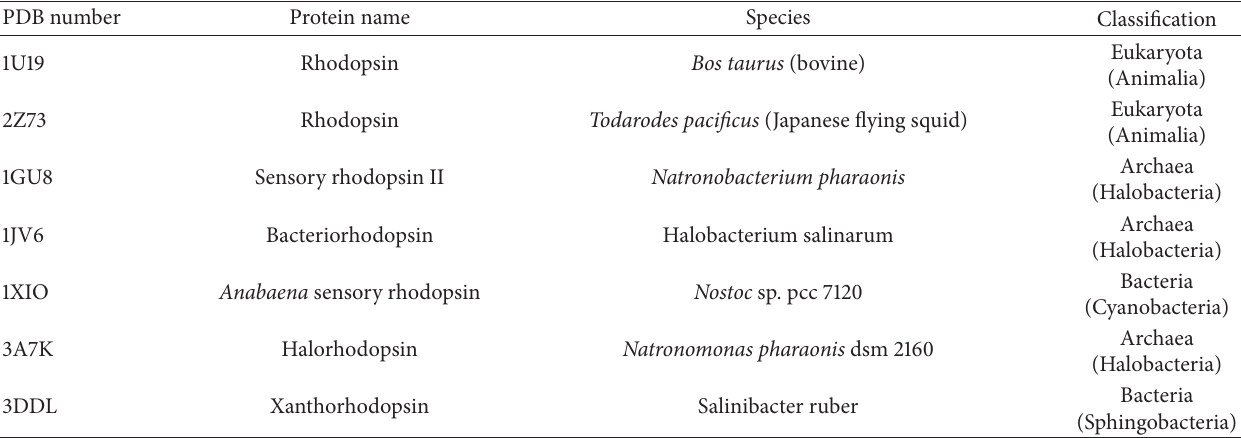
Table 1: PDB accession numbers for two metazoan rhodopsins and five microbial